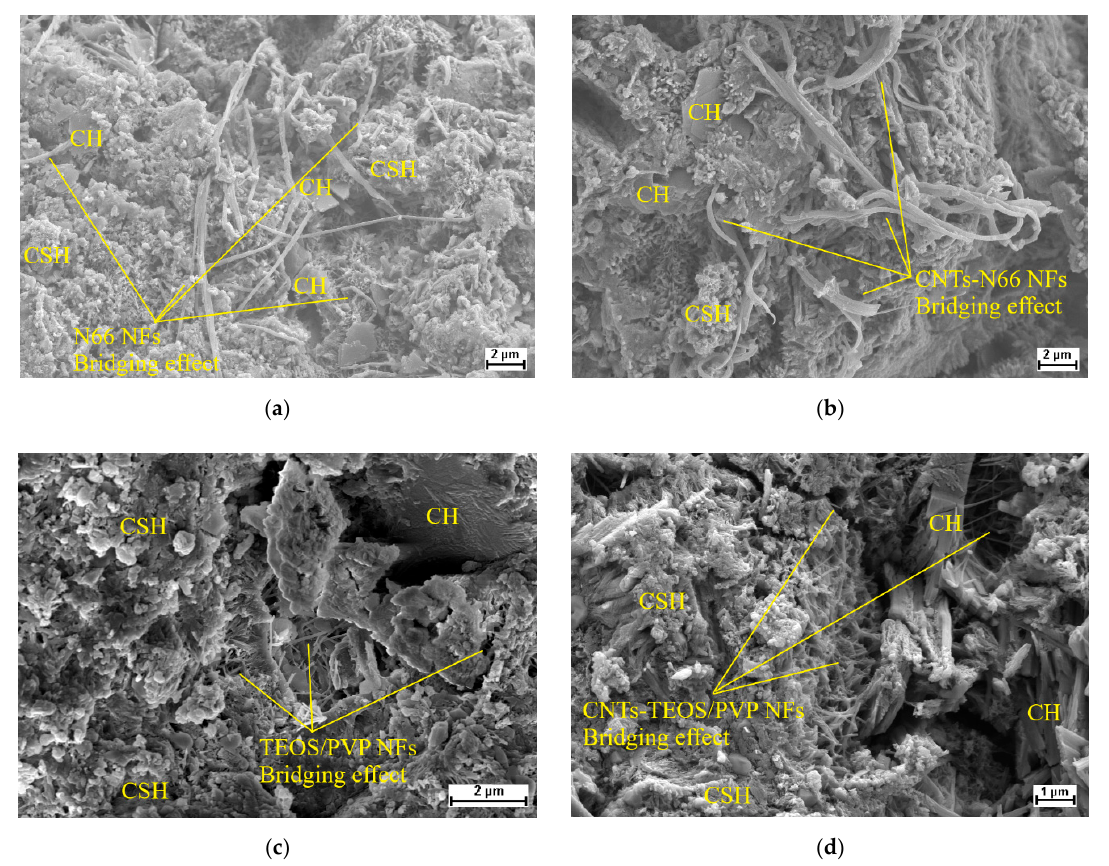
Figure 4. The microstructure of hardened cement paste containing electrospun nanofibers: ( a ) the paste including N66 NFs; ( b ) the paste including CNTs-N66 NFs; ( c ) the paste including TEOS / PVP NFs; ( d ) the paste including CNTs-TEOS / PVP NFs.